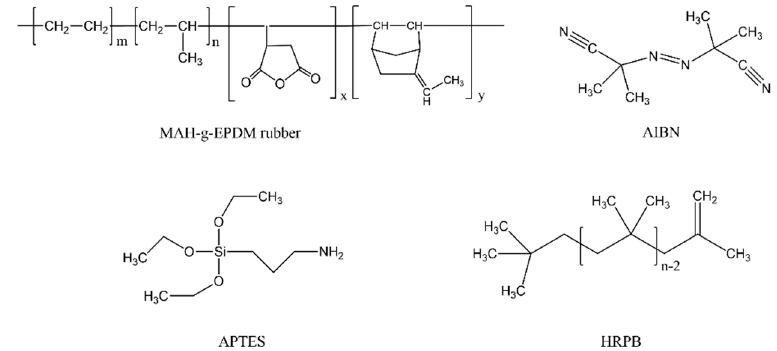
Figure 1. Chemical structures of the raw materials.